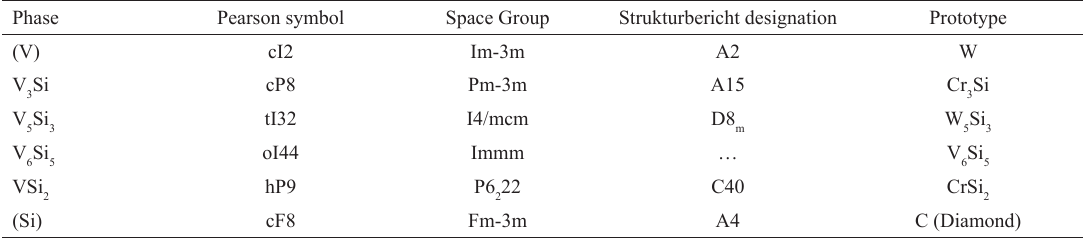
Table 1: Crystallographyc data 11 of the stable solid phases in the V-Si system.